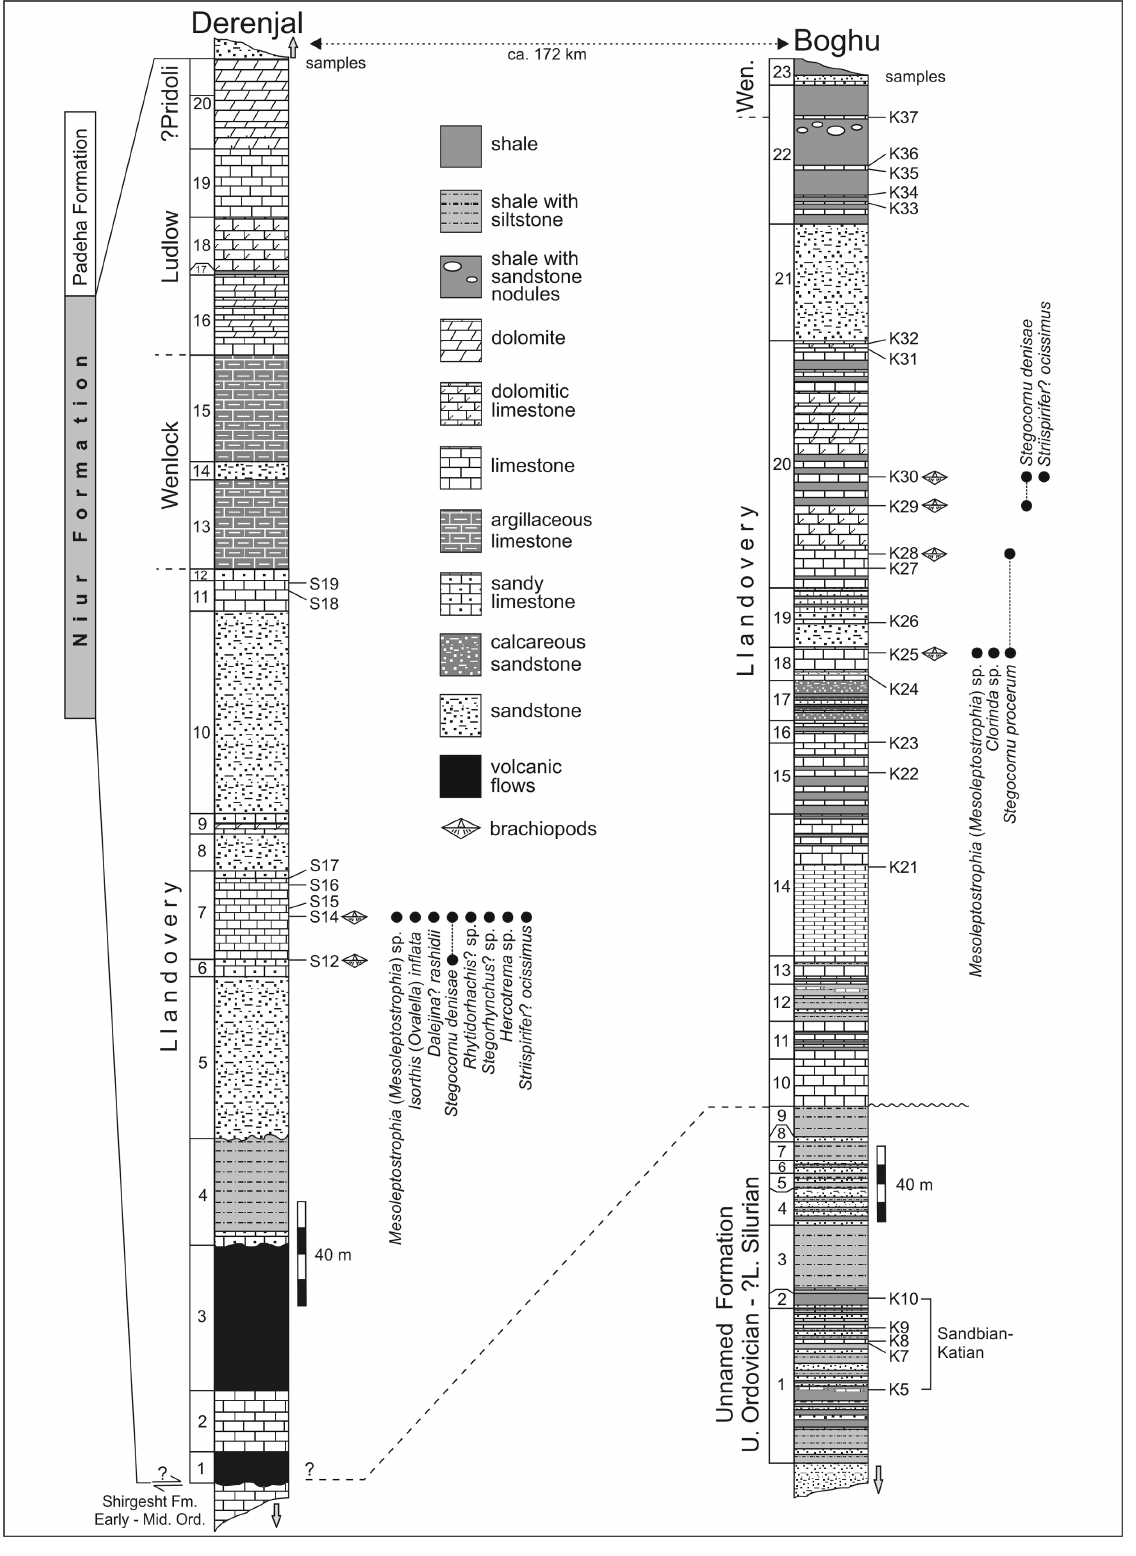
Fig. 2. Stratigraphical columns of the Derenjal and Boghu sections, showing informal lithostratigraphical subdivision of the Niur Formation, position of sampled horizons and stratigraphical distribution of